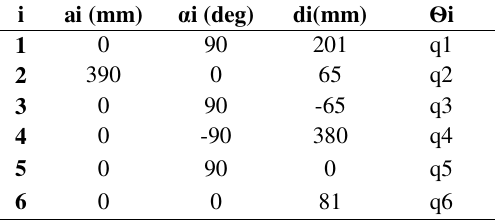
DH Parameters of the EON Robot